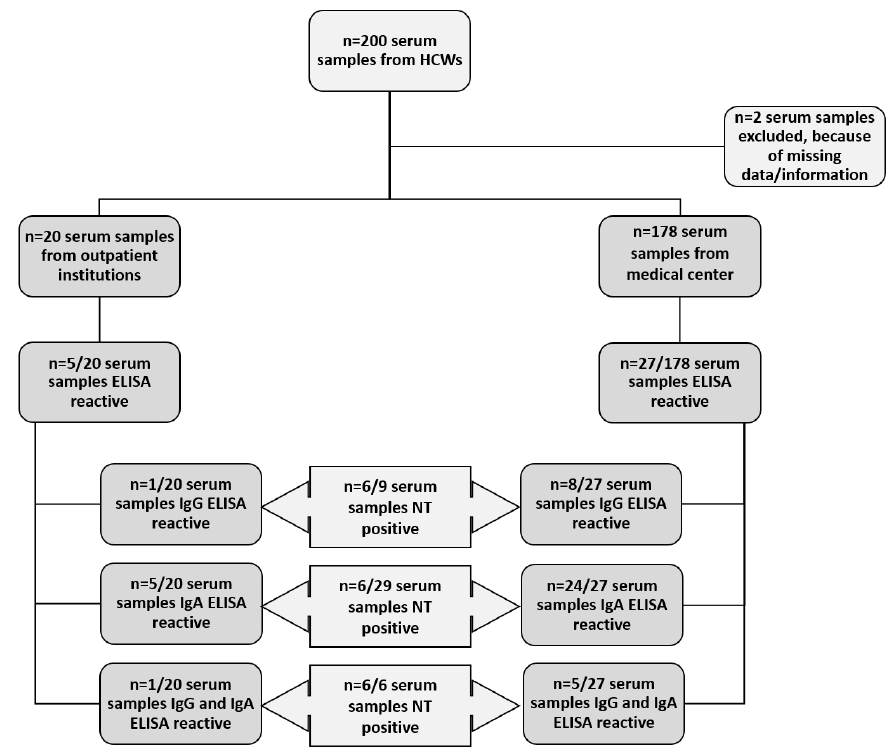
Figure 1. Detailed overview of the serum samples. In total, 198 samples from health care workers (HCWs) were screened using commercially available anti-SARS-CoV-2 ELISAs (IgA and IgG). ELISA-reactive sera were further analyzed using an in-house neutralization assay (NT).